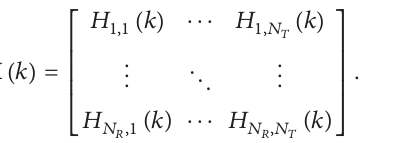
with 𝑋 𝑛 excluded; N C (𝑋; denotes the circular Gaussian pdf with mean ̂𝜏